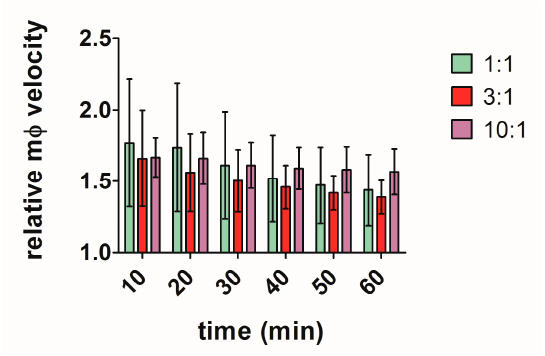
Figure 1. Quantitative analysis of macrophage migration in the presence of different multiplicity of infection (MOI) ratios of wildtype C. albicans . The chart shows mean relative macrophage velocity (relative to macrophage velocity without Candida ) + SD of J774.1 macrophages when cultured with 1:1, 3:1 and 10:1 C. albicans ratios. Statistical significance was evaluated using two-way analysis of